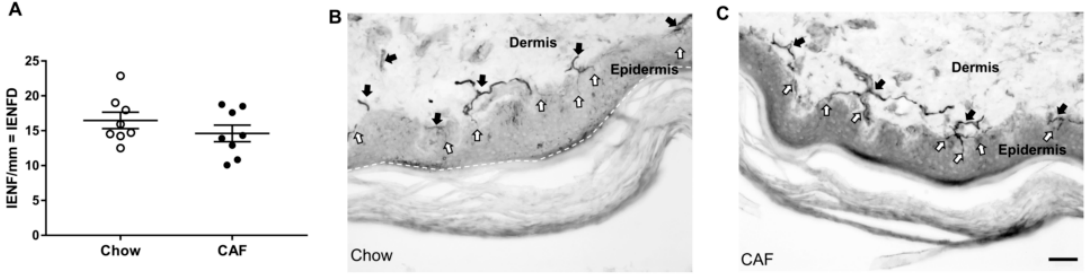
Table 2. Manual von Frey results and parameters of peripheral nerve function obtained with electrophysiological assessments.